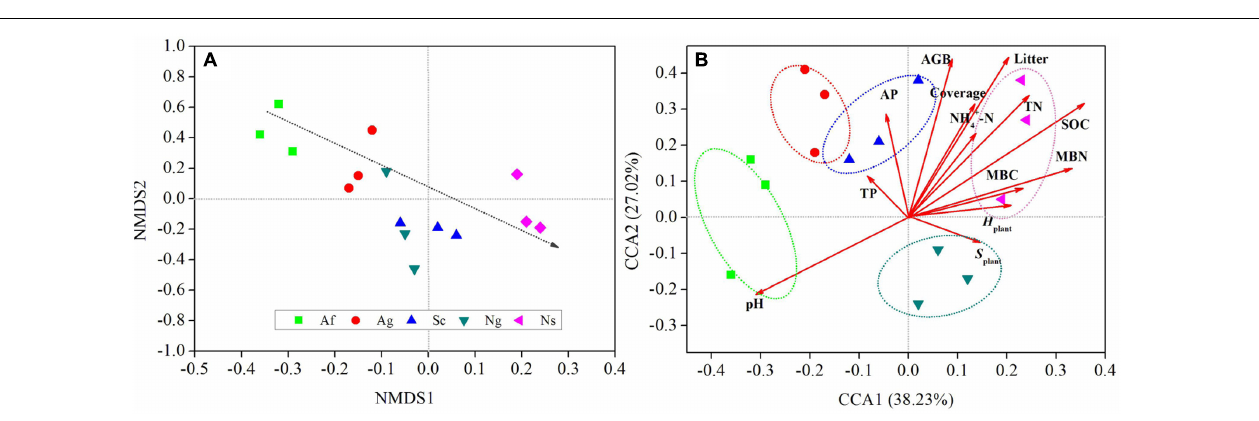
FIGURE 2 | The number of OTUs and relative abundances (%) of fungal phyla among different land use types (A,B) . The ternary sequence diagram of H fungi (Shannon’s diversity index) among the different land use types (C,D) . The gray circles represent H fungi with no significant differences among the different land use types; the blue circles represent H fungi with a significantly higher relative abundance, and the red circles represent H fungi with a significantly lower relative abundance.